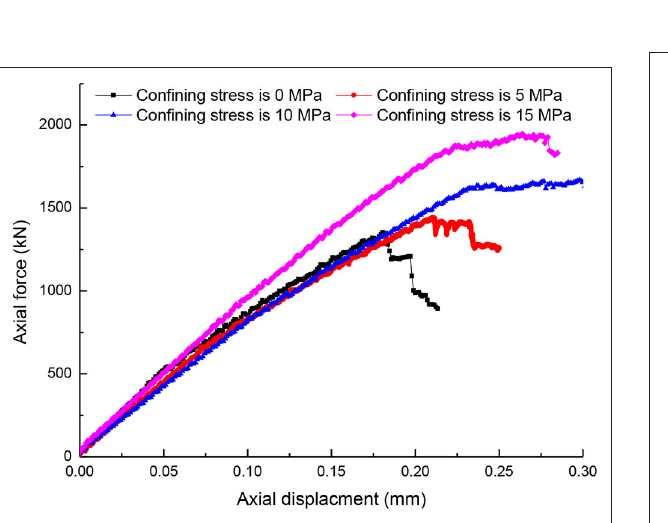
FIGURE 8 | The axial force–displacement curves for various confinements.